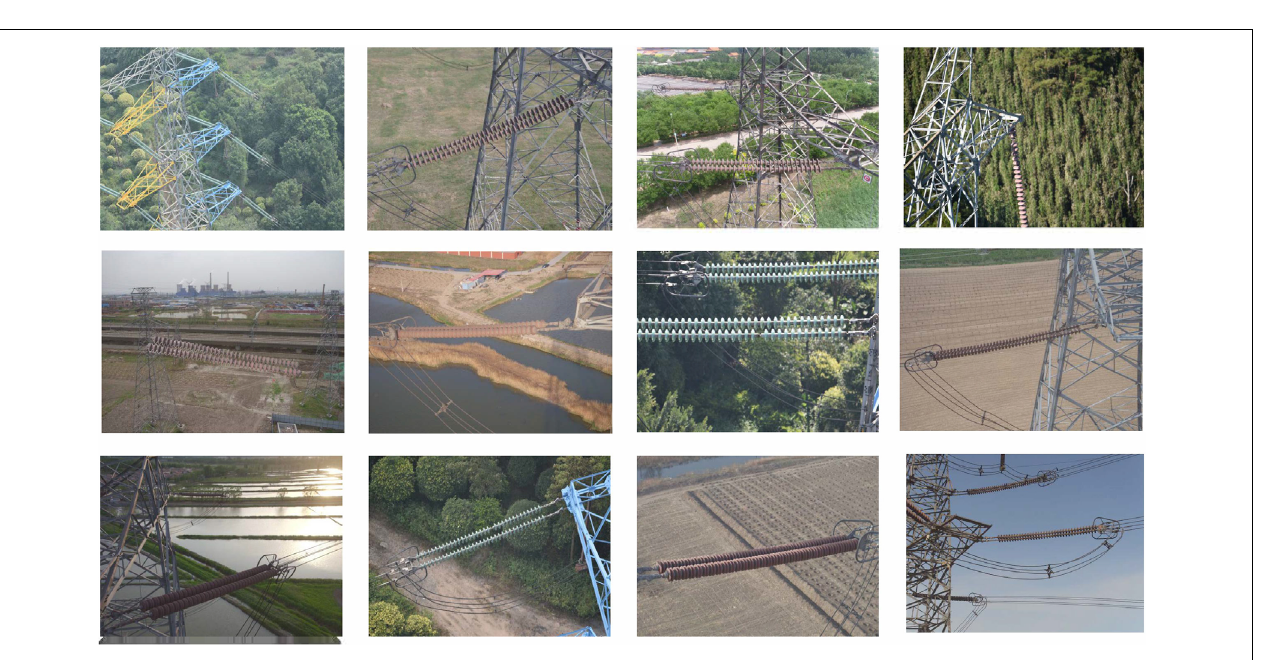
FIGURE 6 | Overview of the dataset constructed